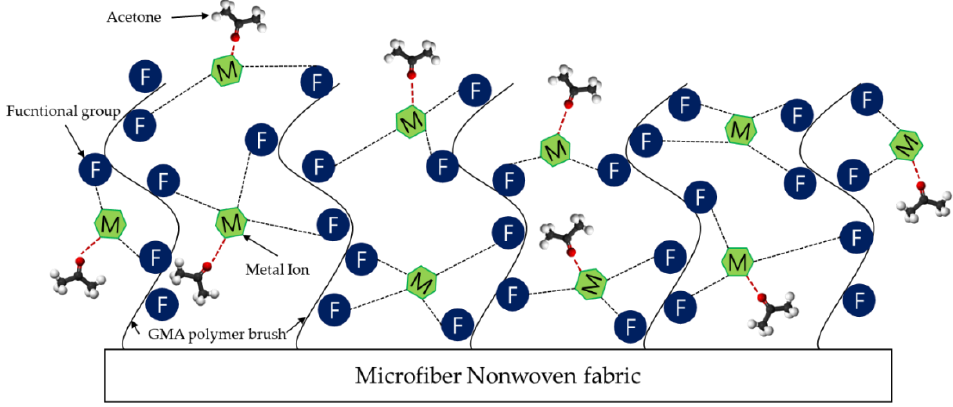
Figure 1. The design concept of a new material in which acetone molecules coordinate to metal ions immobilized on functional microfiber nonwoven fabric.